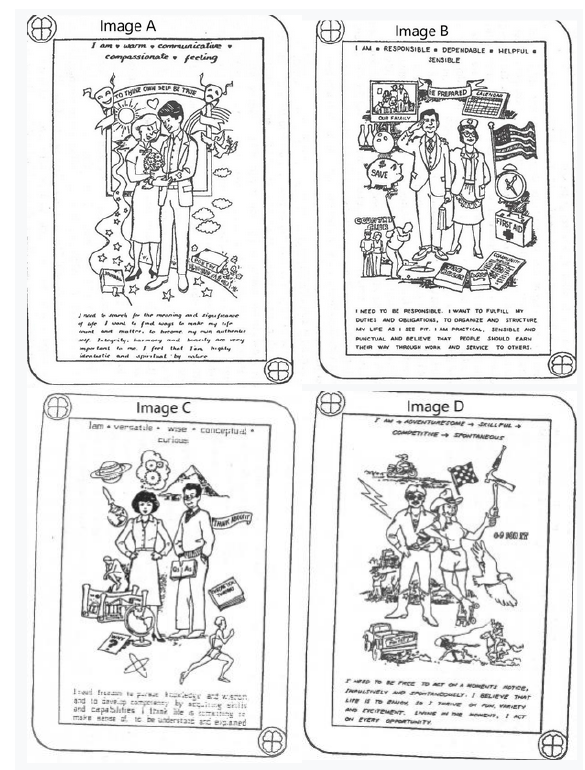
Figure 5. The four images to determine a participant’s True Colors self schema. Image A says “I am warm, communicative,